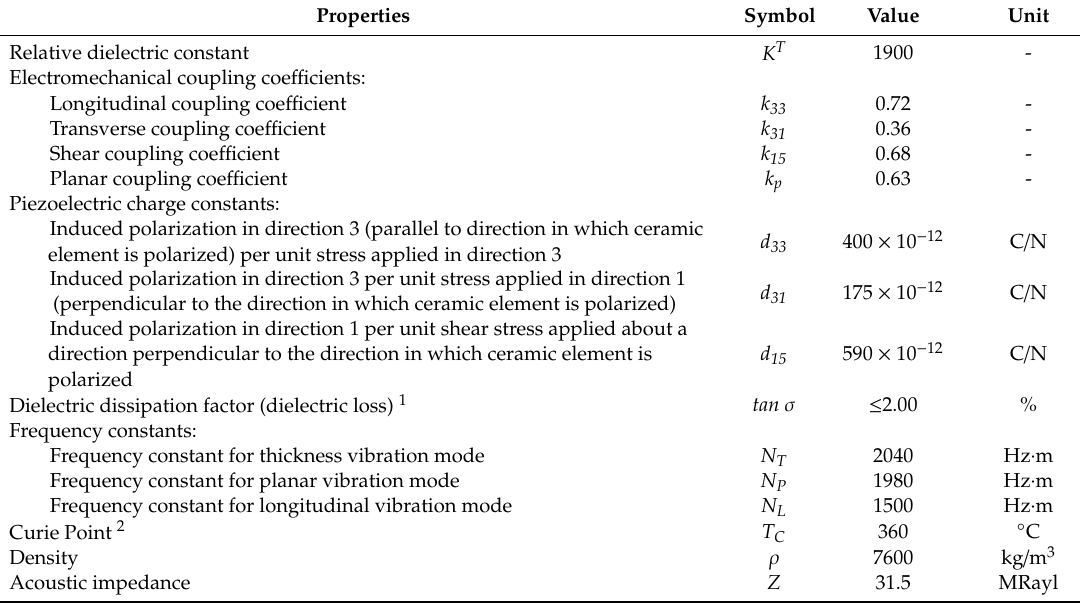
Table 5. Properties of the piezoelectric ceramic used.